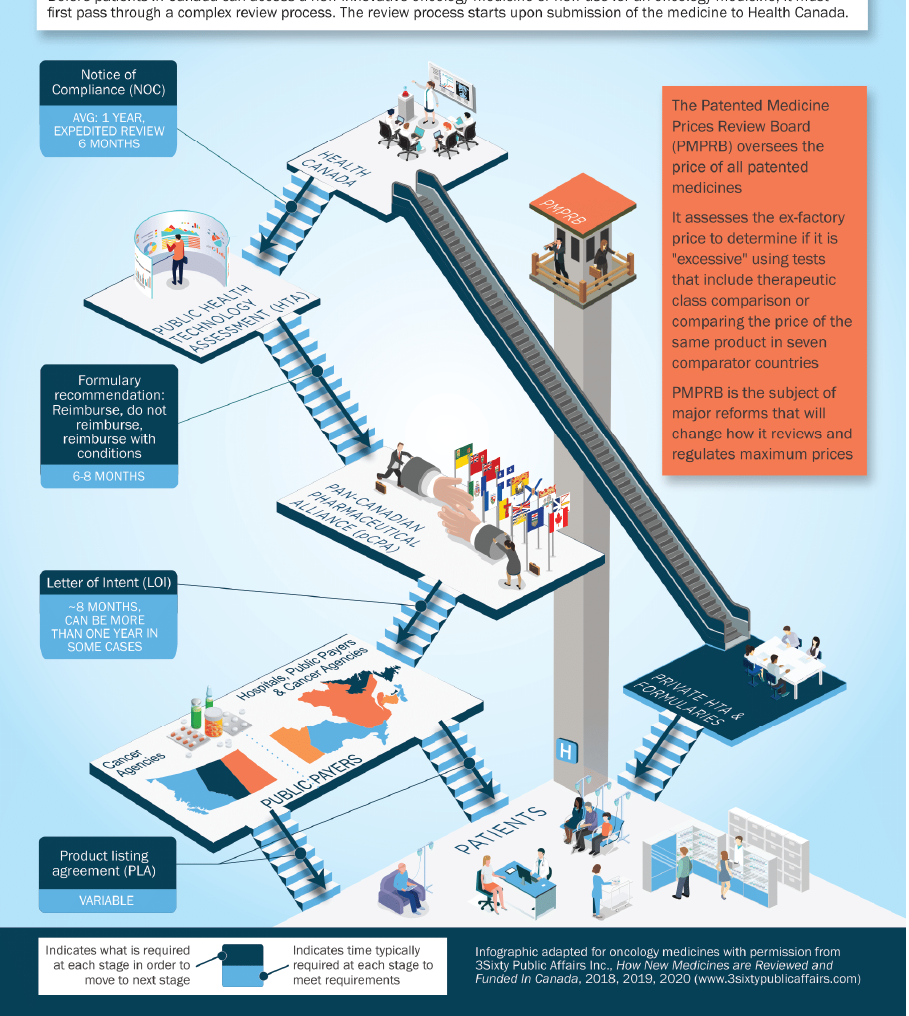
Figure 1. Summary of the cancer drug review and funding process in Canada. Reprinted with permission from Ref. [2].